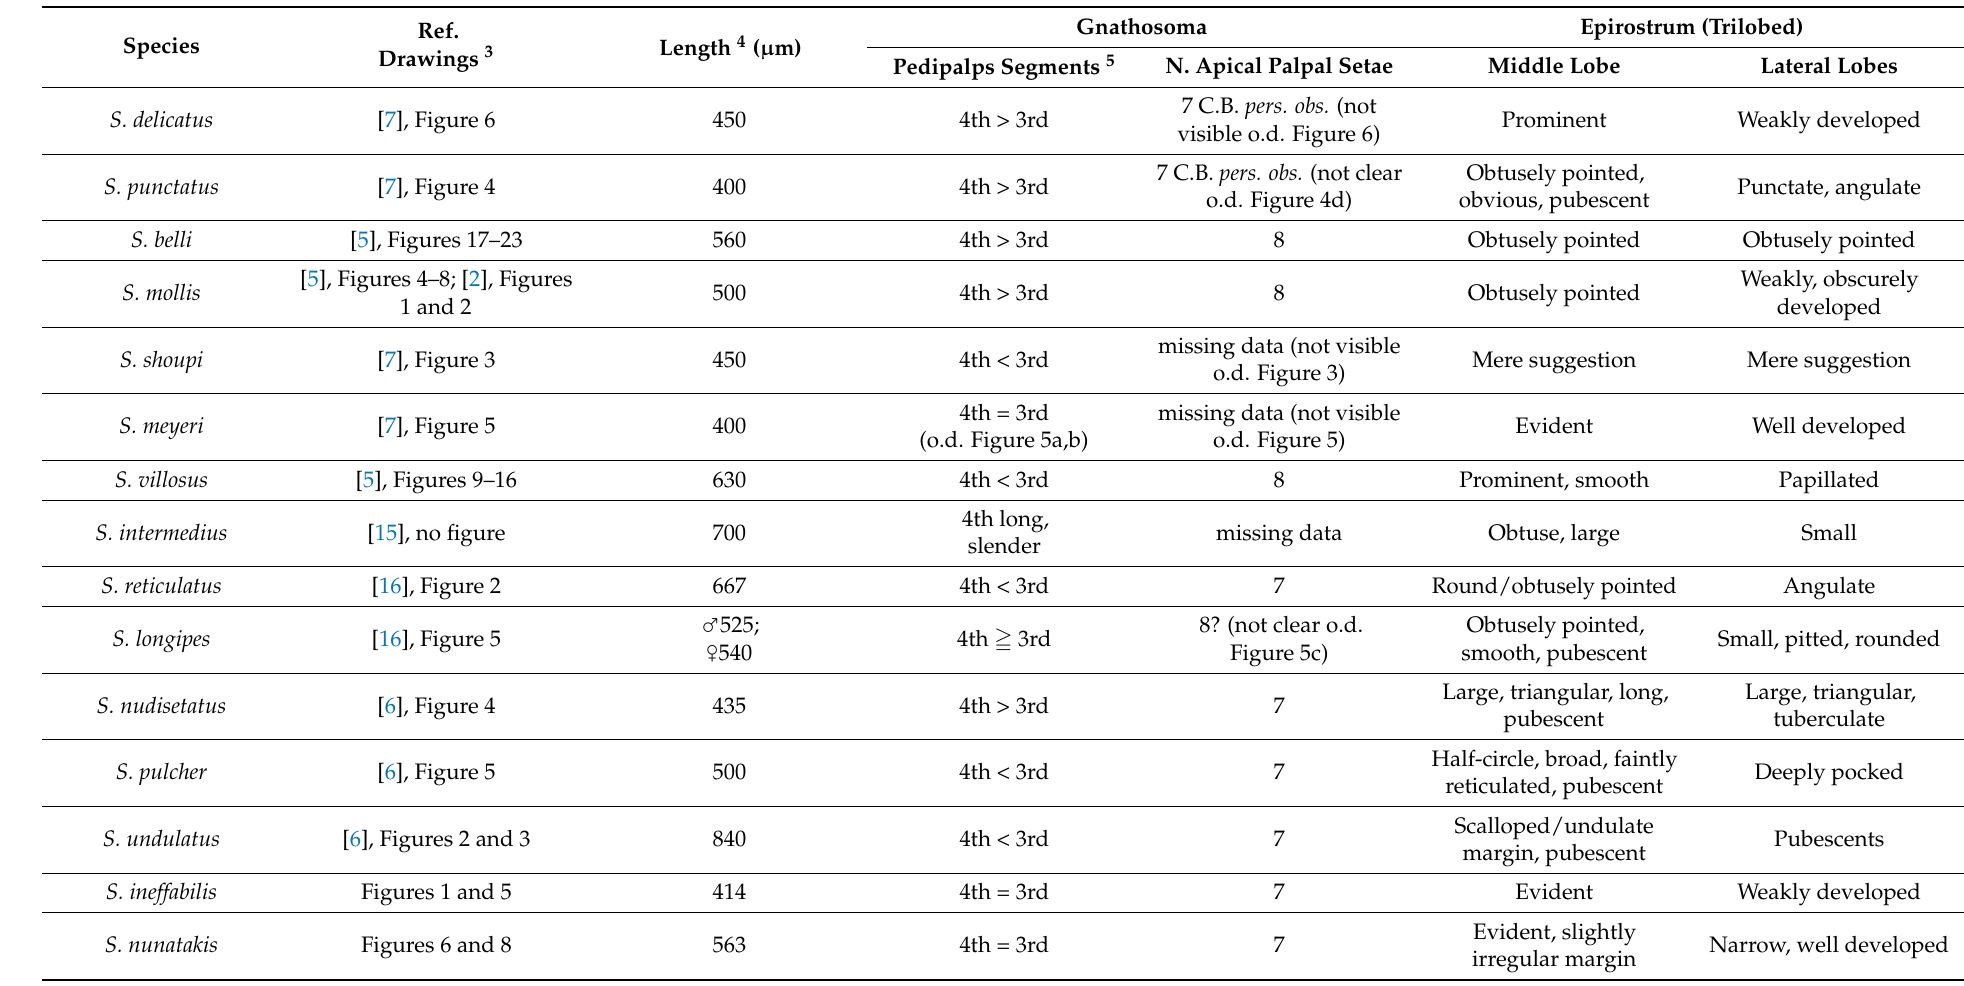
Table A2. Synoptic table of the Antarctic and sub-Antarctic Stereotydeus species with particular attention to the morphological characteristics useful for the identification of the different species. When a characteristic was not in the main text of the description, the reference drawings were used to extrapolate the data and mentioned in the table; on drawing (o.d.).